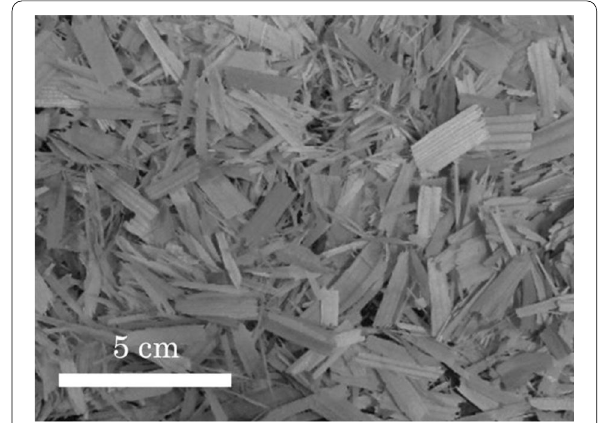
Fig. 1 Sugi ( Cryptomeria japonica ) strands used in the